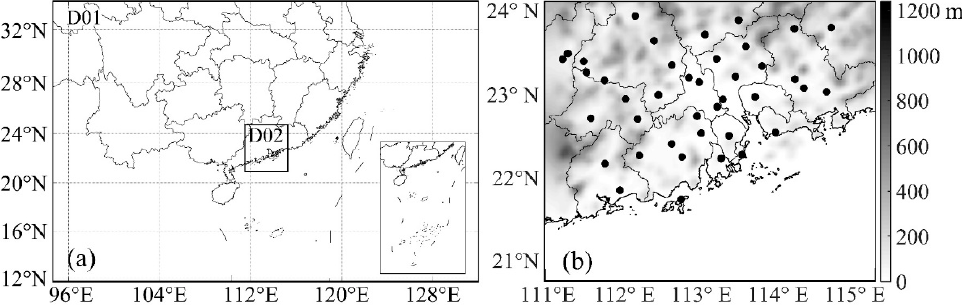
Figure 1. Two nested domains of the Weather Research and Forecast (WRF) ( a ), and the terrain and 40 meteorological stations in the inner domain ( b ).